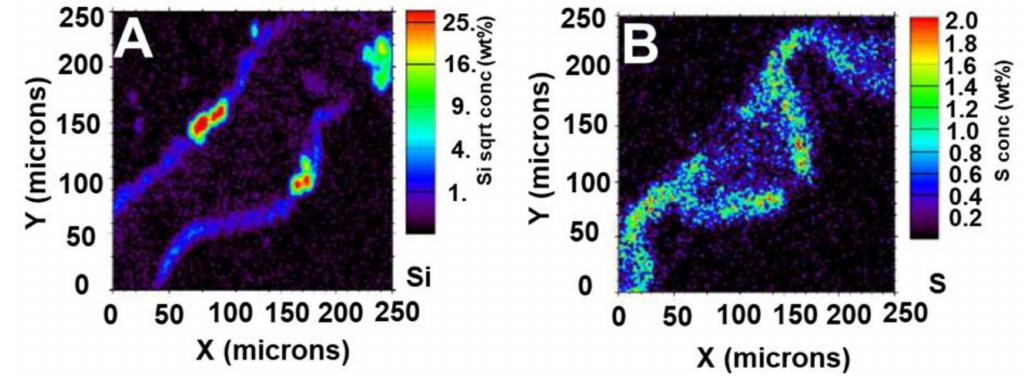
Figure 7. Micro-PIXE images in rice leaf tissue grown with 1 mM silicic acid. ( A ) Silicon detection coinciding with silica cells above and below the vascular bundle. ( B ) Sulphur map. The colour scale on the right side of each image shows the percentage weight detection of each element in that region of the sample. Micro-PIXE analysis was performed at the Jožef Stefan Institute in